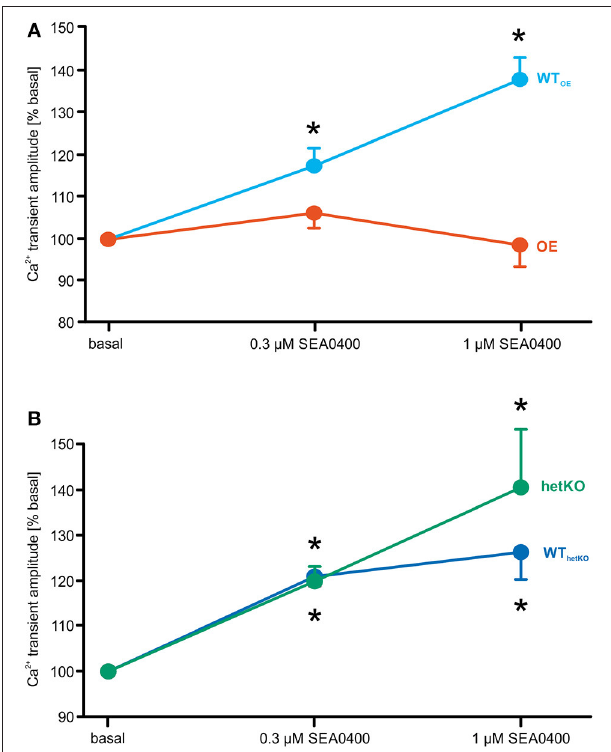
FIGURE 2 | Relative effect of increasing SEA0400 concentrations on the amplitude of field stimulated Ca 2 + transients as a measure for inotropy. SEA0400 mediated a significant relative increase of the Ca 2 + transient amplitude vs. basal in WT OE (A) , WT hetKO and hetKO (B) , but not in OE (A) . Thus, the effect of SEA0400 on the Ca 2 + transient amplitude seems to depend on the respective NCX expression level. * p < 0.05 vs. basal; two-way repeated measures ANOVA